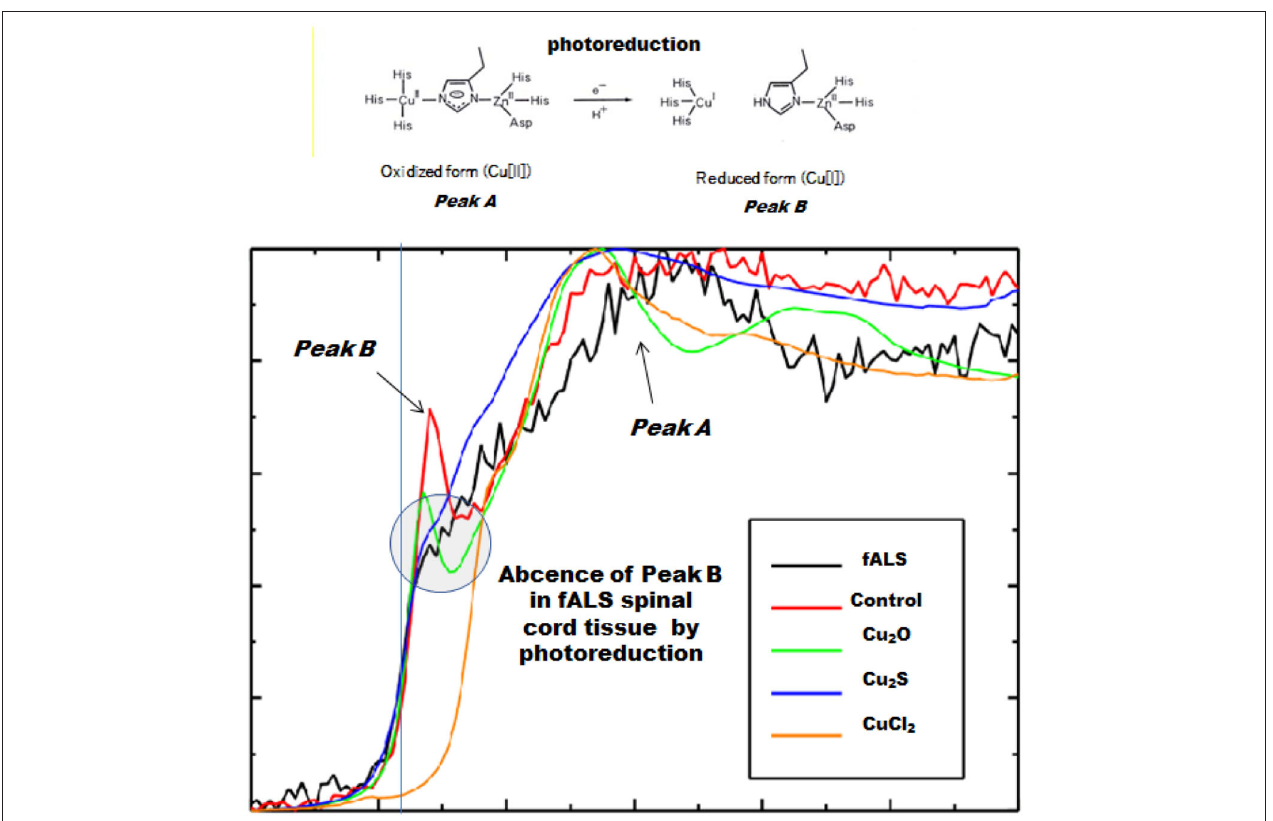
FIGURE 4 | Spectra near the Cu-K absorption edge (XANES). Loss of the pre-edge peak B ( ∼ 8.983 keV) by photoreduction below the Cu-K absorption edge in fALS-1 but not in control-1.